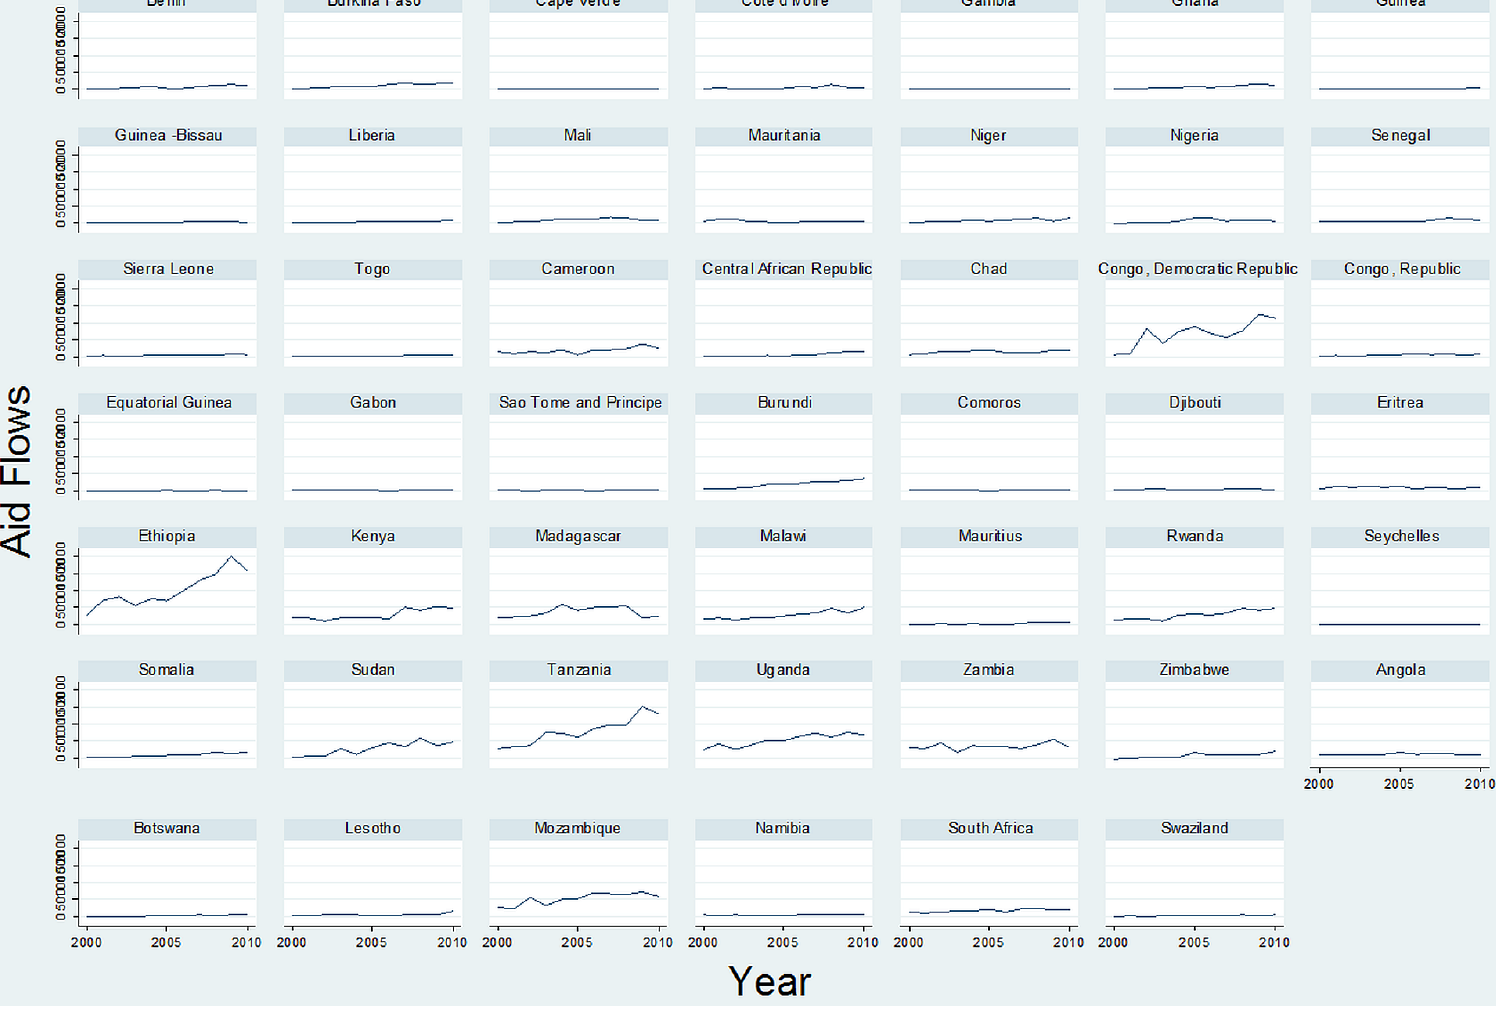
Figure 2. Evolution of the volume of aid towards Sub-Saharan African States,